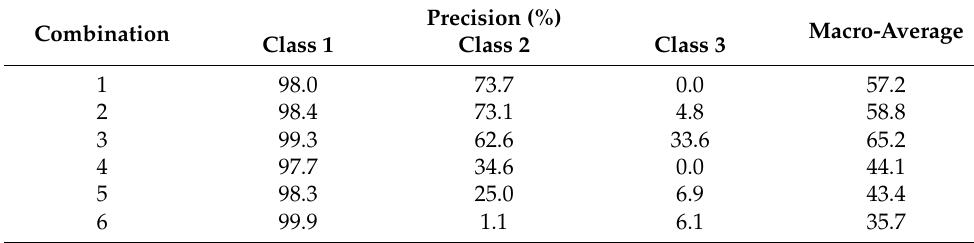
Table 3. Precisions of three-class classification problem for six combinations before SMOTE-NC